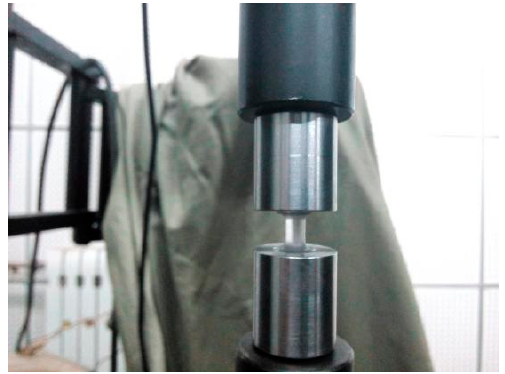
Figure 3. The fixture device connecting the specimen in quasi-static tension tests.